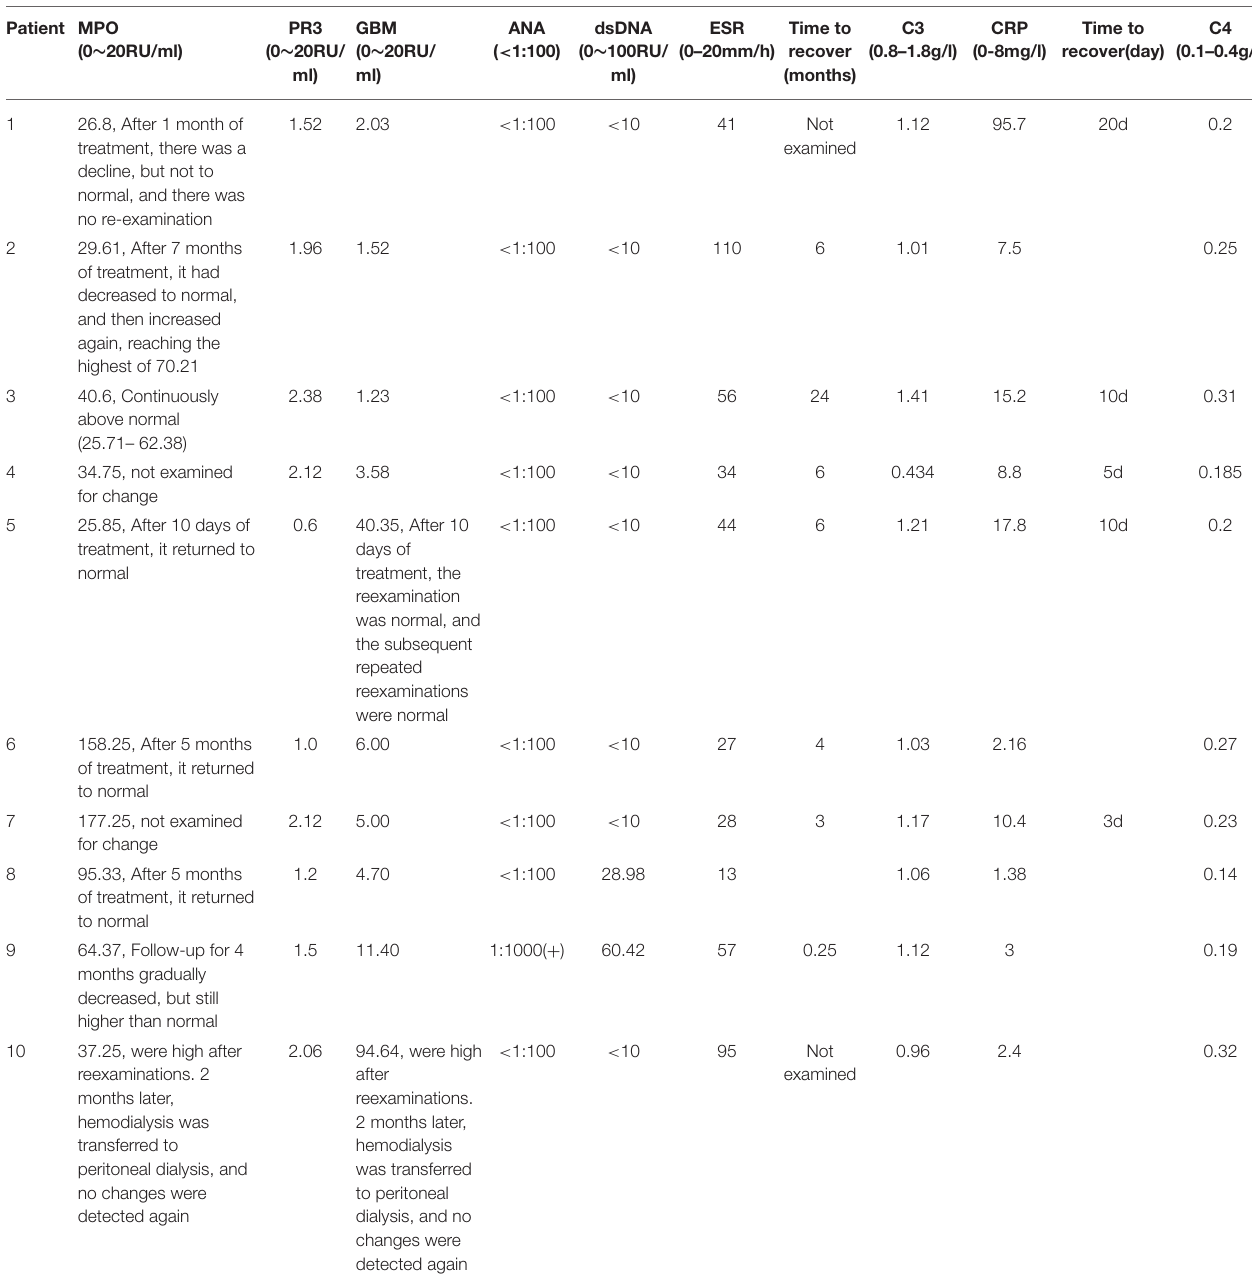
TABLE 3 | Summary of laboratory tests of 10 children with MPA. Patient MPO (0 ∼